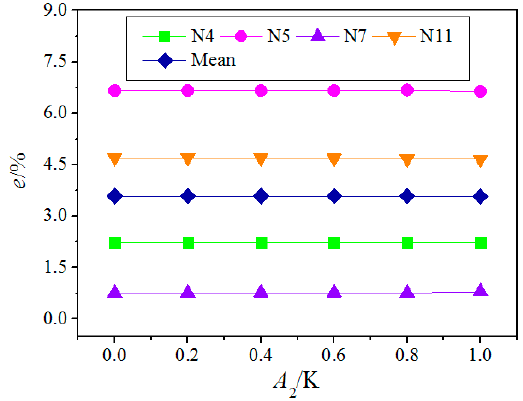
Figure 10. Effect of fluctuation amplitude of pyrolysis temperature on monitoring precision. A 2 : (the fluctuation amplitude of pyrolysis temperature); e : (the relative errors of NAMW of PEW).